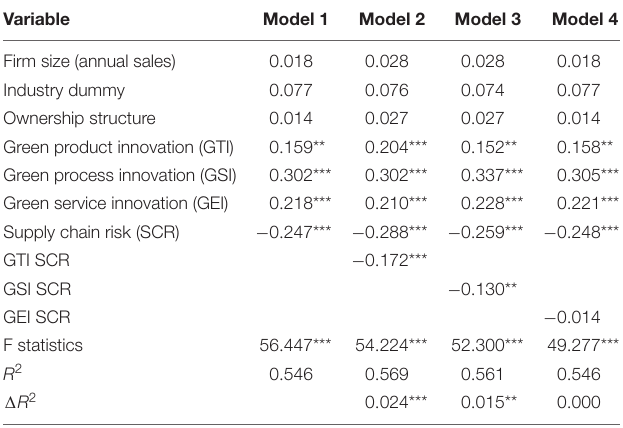
TABLE 3 | Results of hierarchical regression